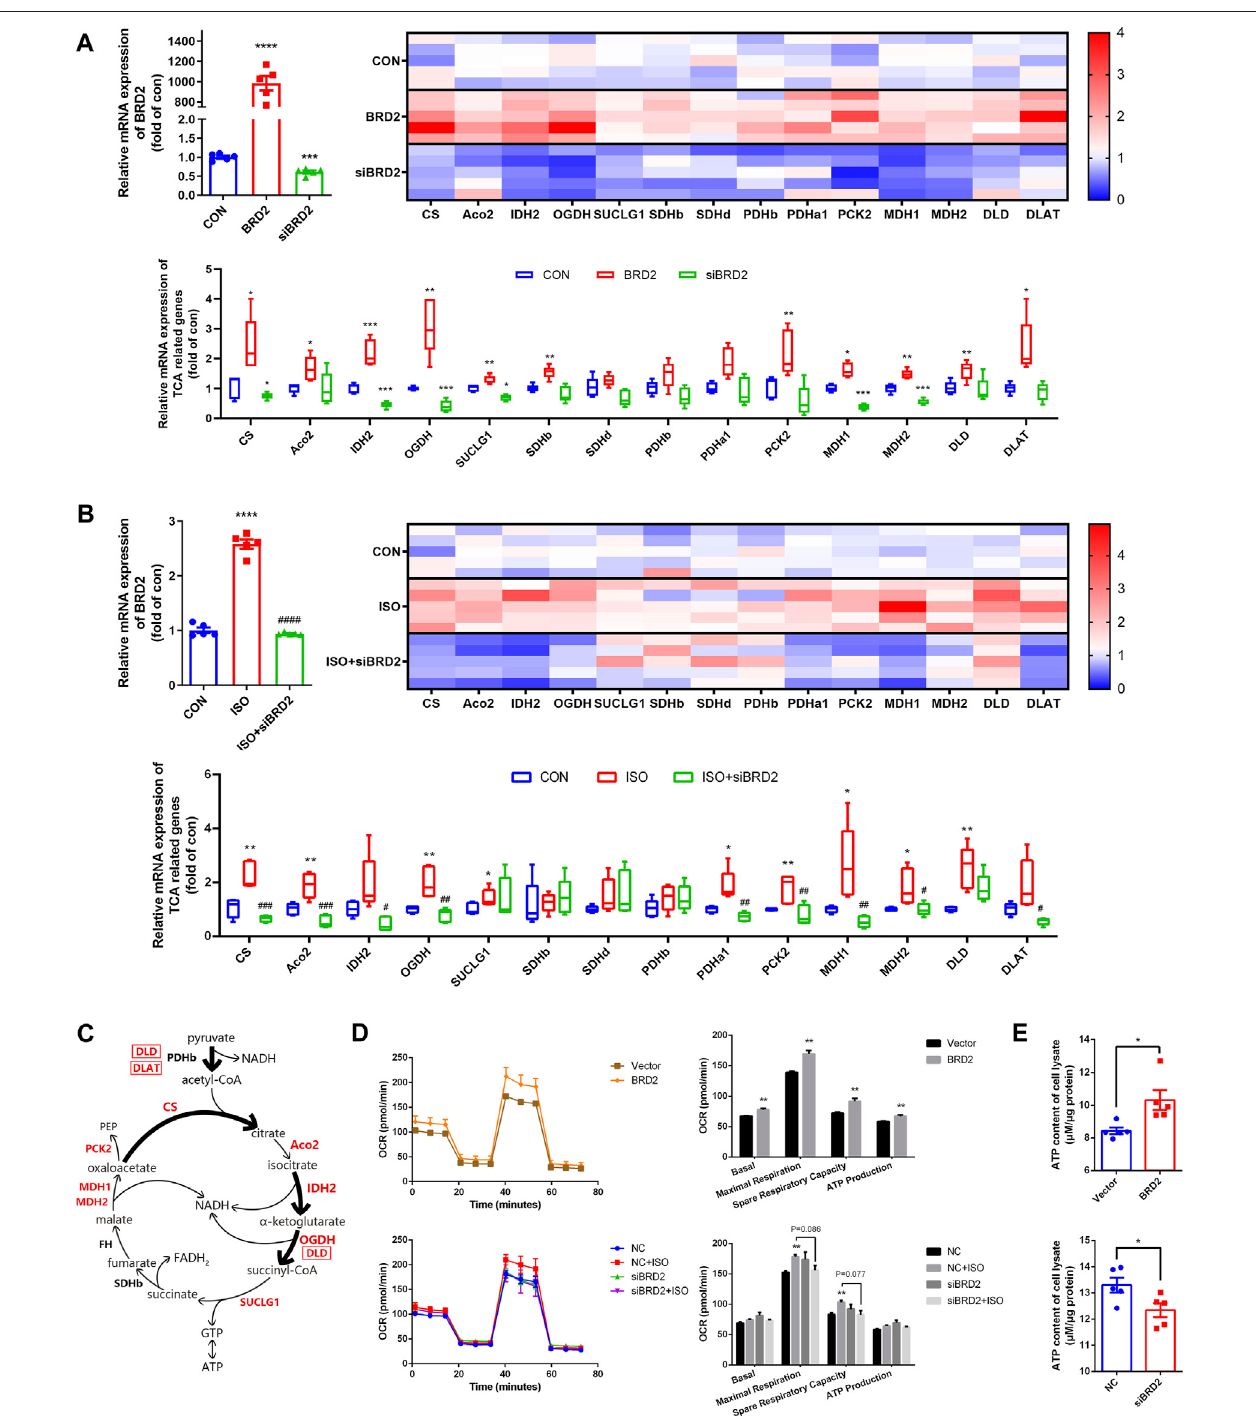
FIGURE 5 | BRD2 modulated expression of TCA cycle genes and energy production during ISO-induced cardiac hypertrophy. qPCR measurement of TCA cycle genes in (A) NRCMs with BRD2 overexpression or knockdown, and (B) NRCMs with or without BRD2 knockdown or ISO treatment. (C) Schematic diagram showing TCA genes changes following ISO treatment in NRCMs. (D) Oxygen consumption rates (OCR) measured by XF Cell Mito Stress Test Kit. (E) ATP production in cardiomyocytes with BRD2 overexpression or knockdown. The data are presented as mean ± SEM, * p < 0.05, ** p < 0.01, *** p < 0.001 vs. control, **** p < 0.0001 vs. control. # p < 0.05, ## p < 0.01, ### p < 0.001 vs. ISO, #### p < 0.0001 vs. ISO. n = 5.